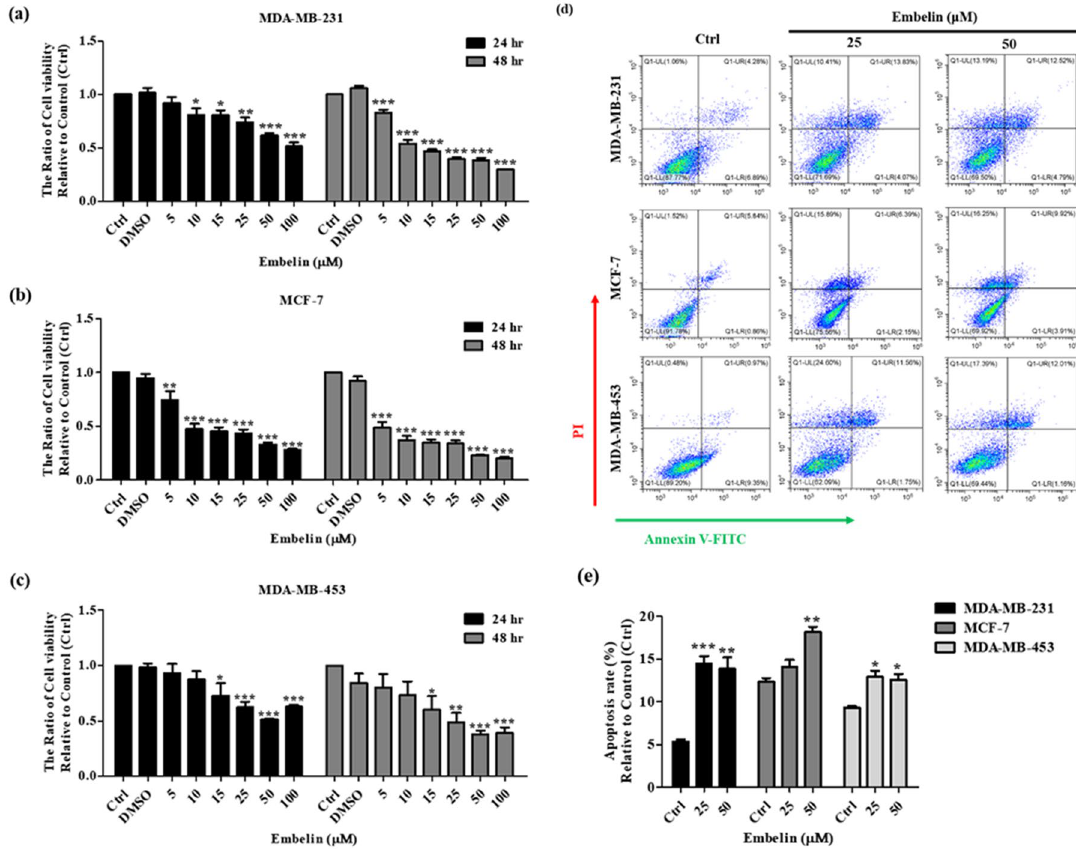
Figure 1. The effect of embelin on breast cancer cell lines. ( a ) MDA-MB-231, ( b ) MCF-7 and ( c ) MDA-MB-453 were treated with embelin at different concentrations (0, 5, 10, 15, 25, 50, 100 μM) for 24 h and 48 h. The results were detected by MTT assay and multimode microplate readers at a wavelength of 545 nm. ( d ) Annexin V/ propidium (PI) dye was used to determine the rate of apoptosis following treatment with 25 or 50 μM embelin for 24 h in three breast cancer cell lines. ( e ) Quantitative graphs of the apoptotic rate of ( d ). Data were shown as mean ± SEM and analyzed by one-way ANOVA with Dunnett’s test. (n = 3, * P < 0.05, ** P < 0.01, *** P <